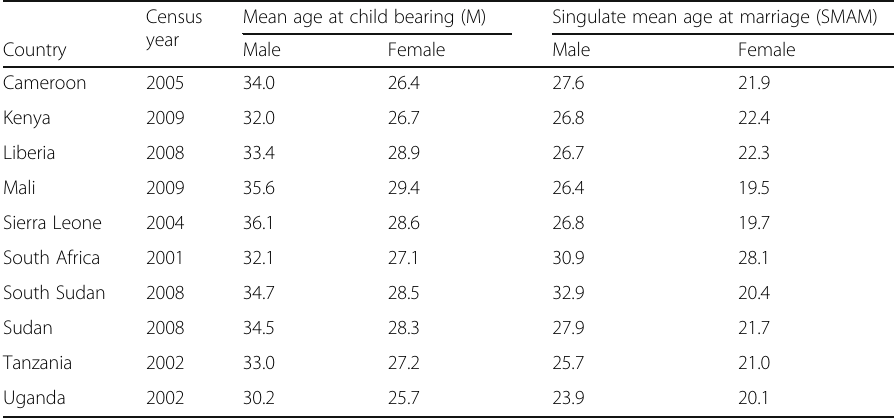
Table 2 Mean age at childbearing and singulate mean age at marriage by selected sub-Saharan countries Census Mean age at child bearing (M) Singulate mean age at marriage (SMAM) year Country